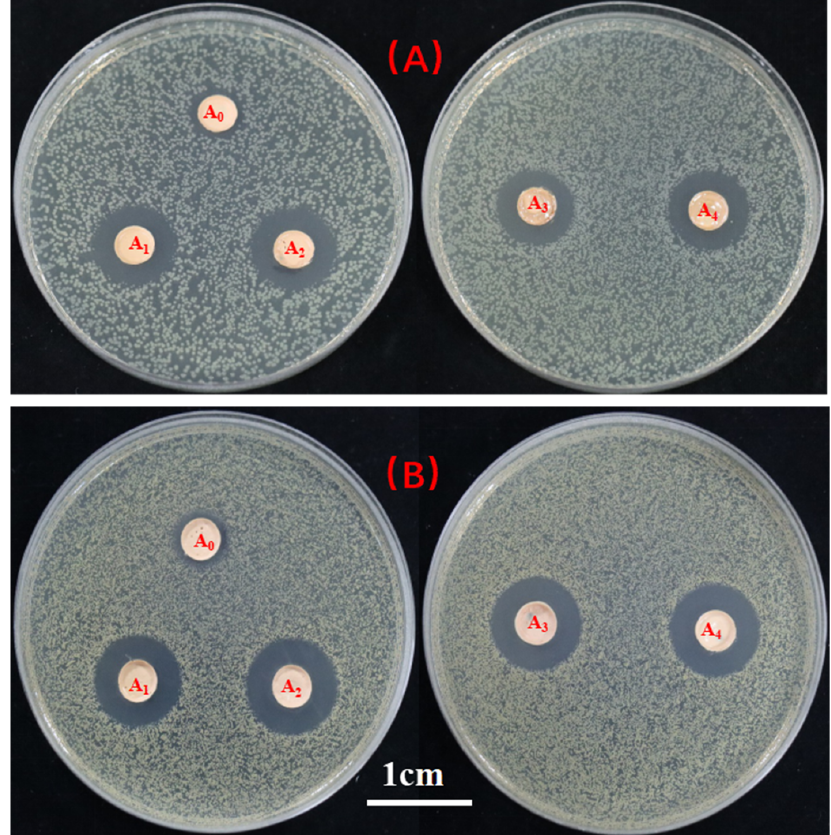
Figure 8. ( A ) A 0 − A 4 image of the inhibition zone in Escherichia coli and ( B ) A 0 − A 4 image of the inhibition zone in Staphylococcus aureus .